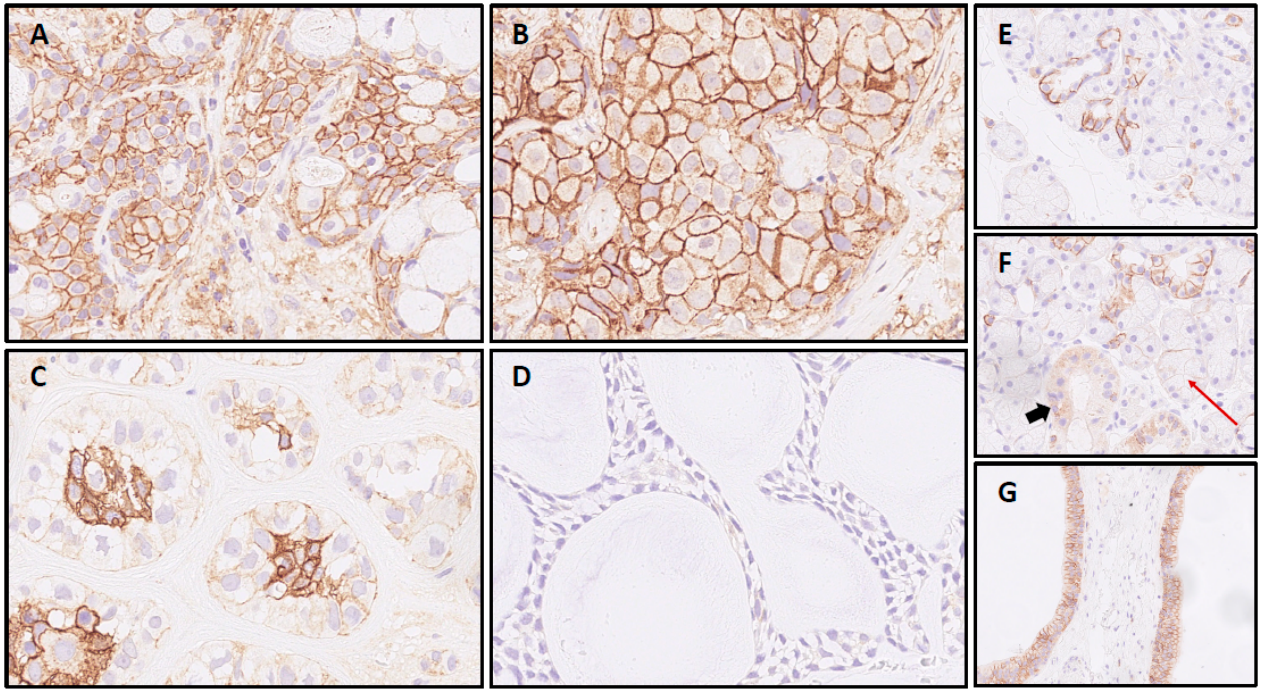
Figure 1. CD138 IHC in salivary gland carcinomas: Mucoepidermoid carcinoma ( A ) and salivary duct carcinoma sample ( B ), both with intense circumferential staining of >95% of cells. Epithelial- myoepithelial carcinoma ( C ) with signal restricted to luminal cells and adenoid cystic carcinoma case ( D ) with negativity for CD138; CD138 expression in normal submandibular gland tissue: ( E ) Most intercalated ducts with partial membranous staining in contrast to ( F ) striated ducts without membranous signal (cytoplasmatic positivity, bold arrow) and acini with negativity for CD138 (red arrow). ( G ) Two excretory ducts with basolateral SDC1 expression in >90% of duct epithelia.